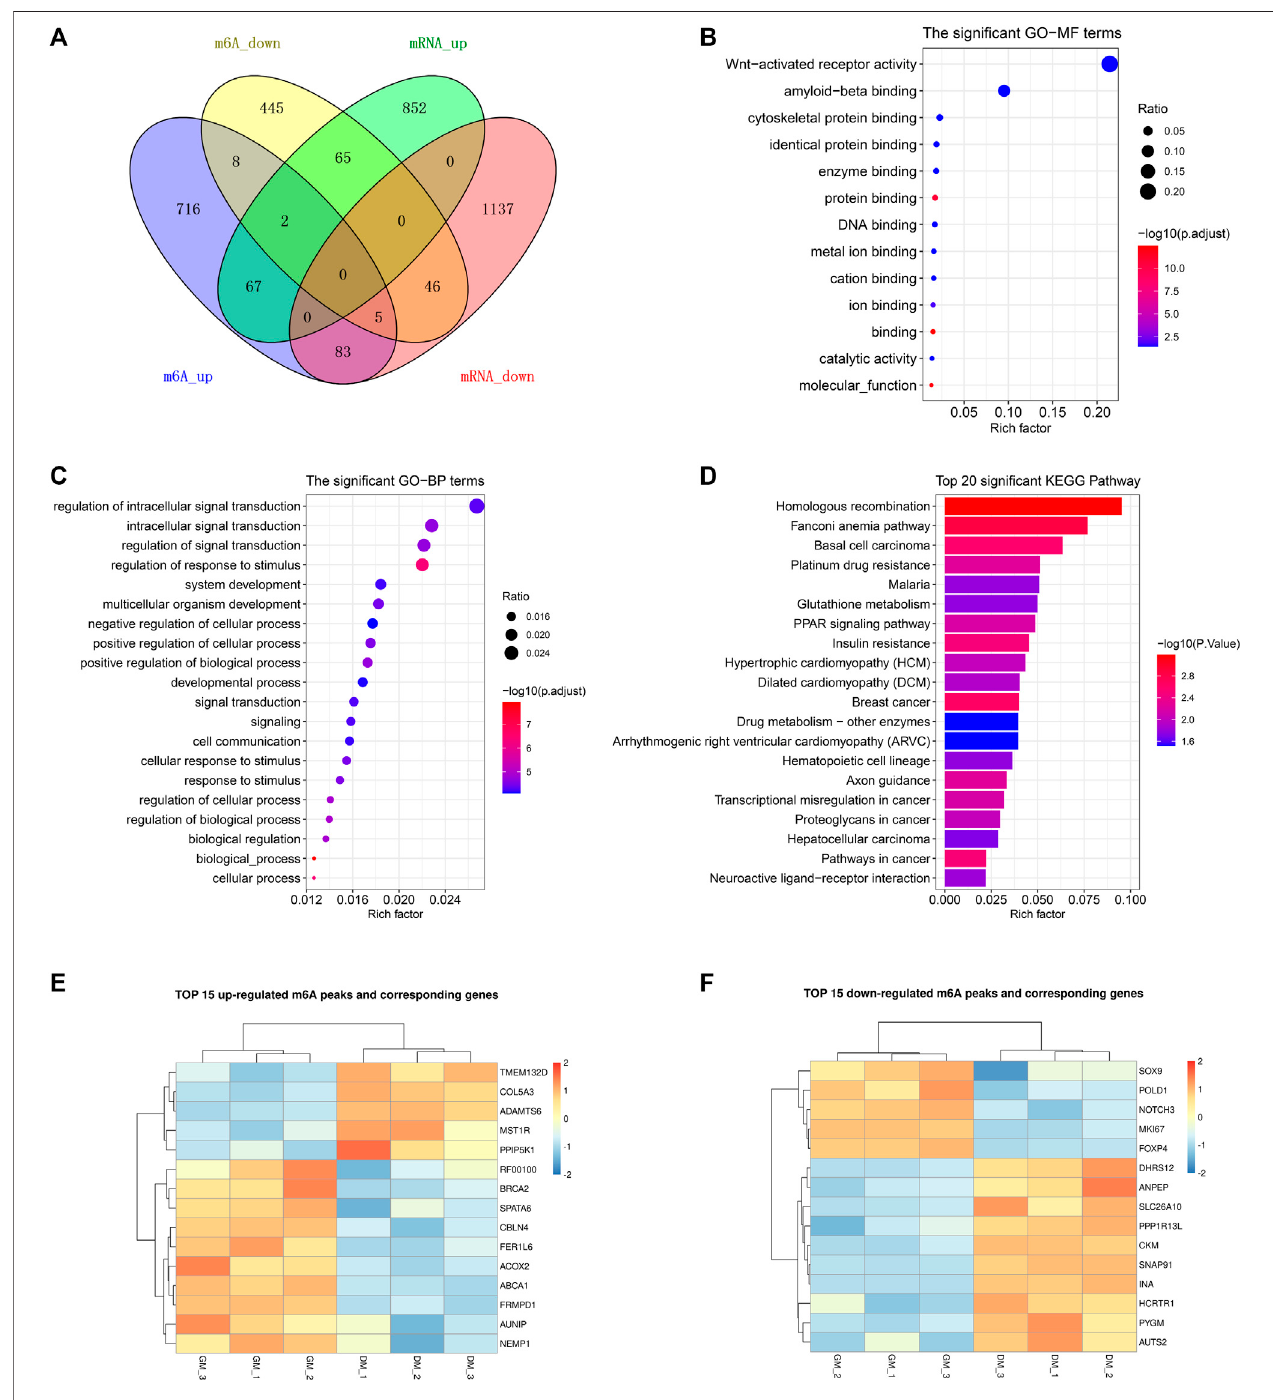
FIGURE 5 | Conjoint analysis of m 6 A-seq and RNA-seq data. (A) Venn diagram showing the overlapping genes between DMPs and DEGs. (B) GO analysis of molecular function for common genes between DMGs and DEGs. (C) GO analysis of biological process for common genes between DMGs and DEGs. (D) KEGG analysis of common genes between DMGs and DEGs. (E) Heatmap of 15 genes mRNA expression in Table 3 . (F) Heatmap of 15 genes mRNA expression in Table 4 .